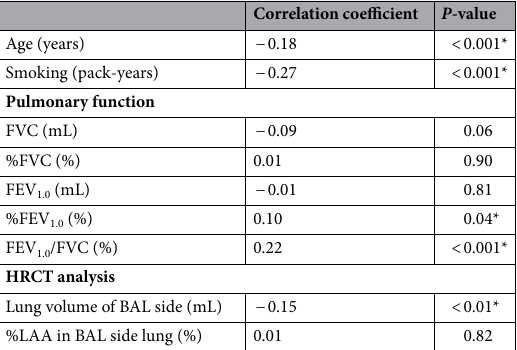
Table 2. Correlation of clinical, physiological, and radiological parameters with BALF recovery rate. FVC forced vital capacity, %FVC percent predicted FVC, FEV 1.0 forced expiratory volume in one second, %FEV